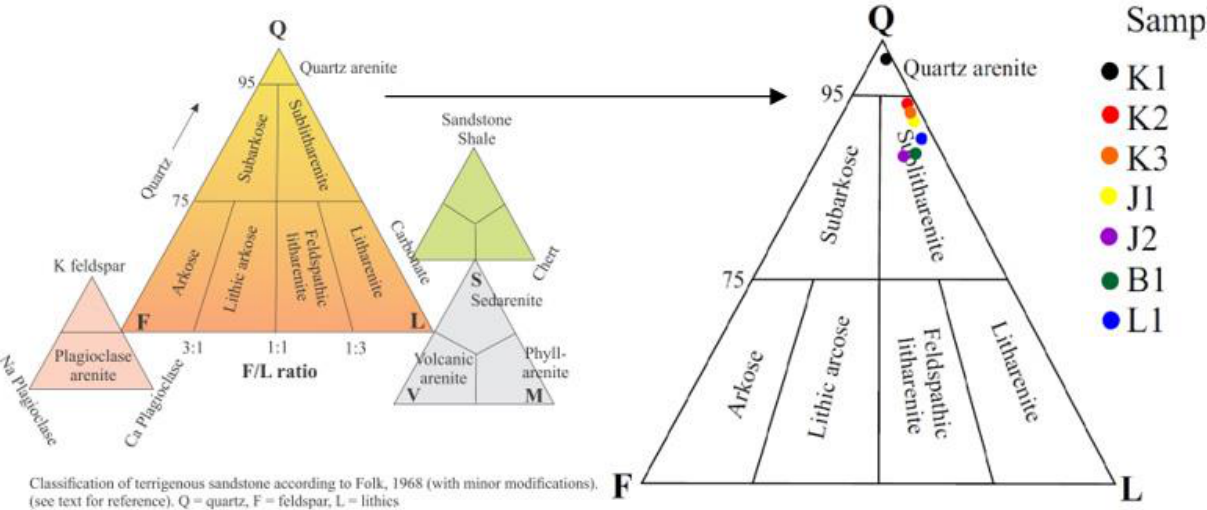
Figure 16. Classification of tested sandstones according toFolk triangle [24,25].